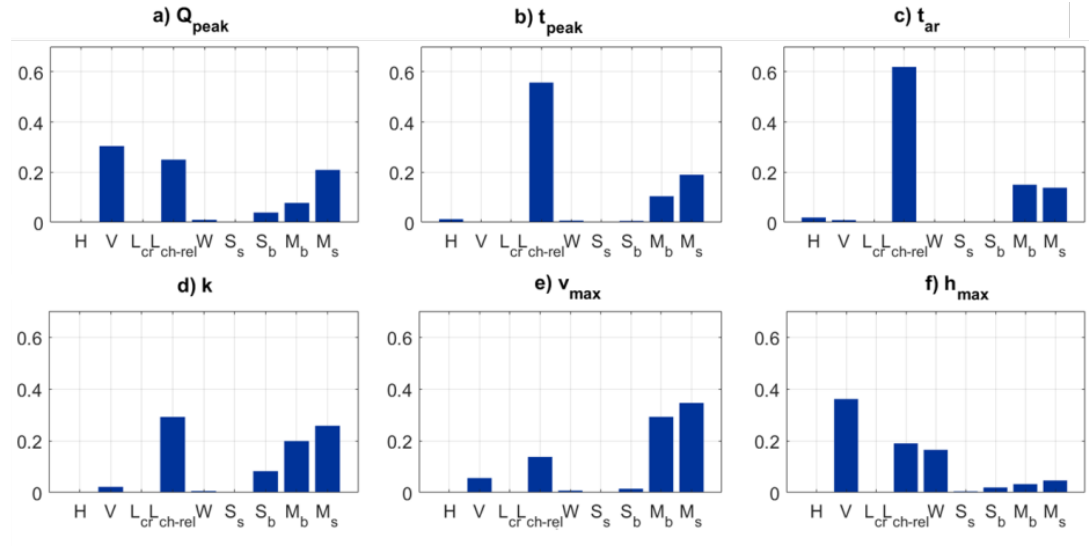
Figure 10. 1st order Sobol’ indices of ( a ) Q peak ; ( b ) t peak , ( c ) t ar ; ( d ) k ; ( e ) v max ; and ( f ) h max ; to the model inputs